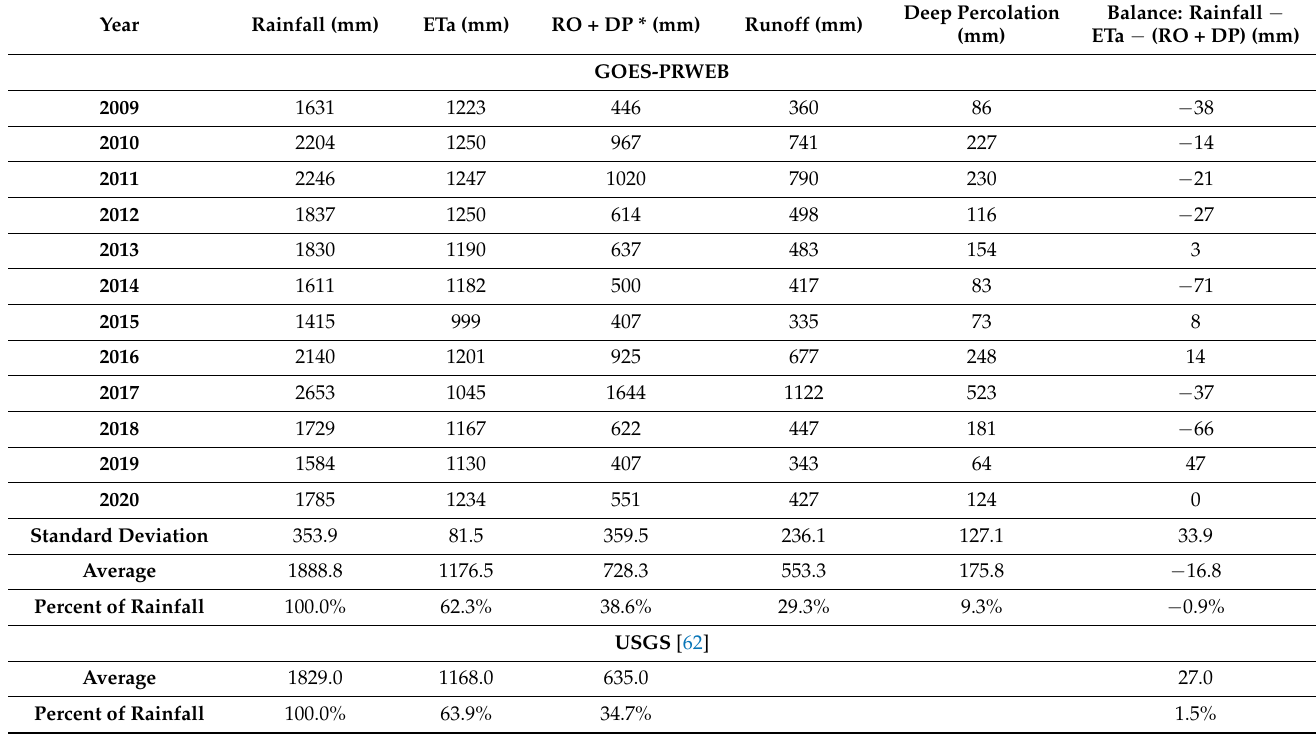
Table 5. Water balance components for Puerto Rico,